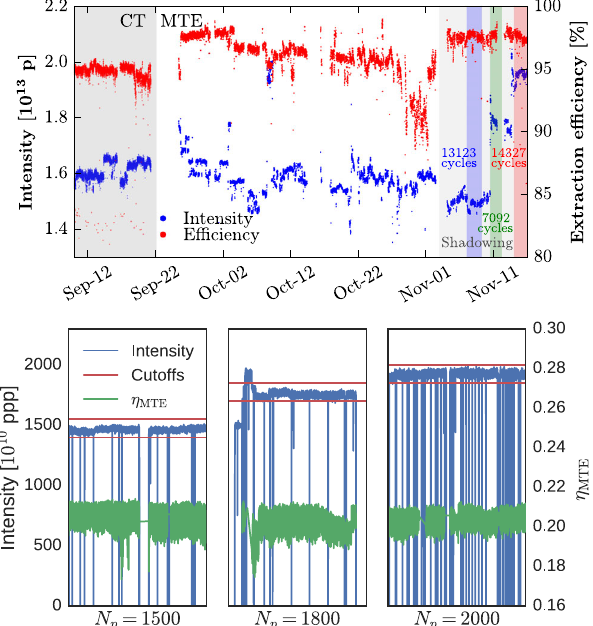
FIG. 10. Upper: Evolution of the PS beam intensity and extraction efficiency during the 2015 MTE run (from Ref. [25]). The three colored regions towards the end of the run correspond approximately to the selected time frames used in the analysis reported here. Bottom: PS intensity over time, shown together with the cuts in intensity, and η MTE